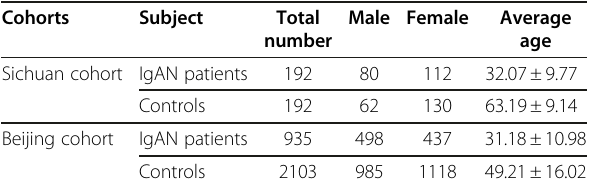
Table 1 Characteristics of primary IgAN cases